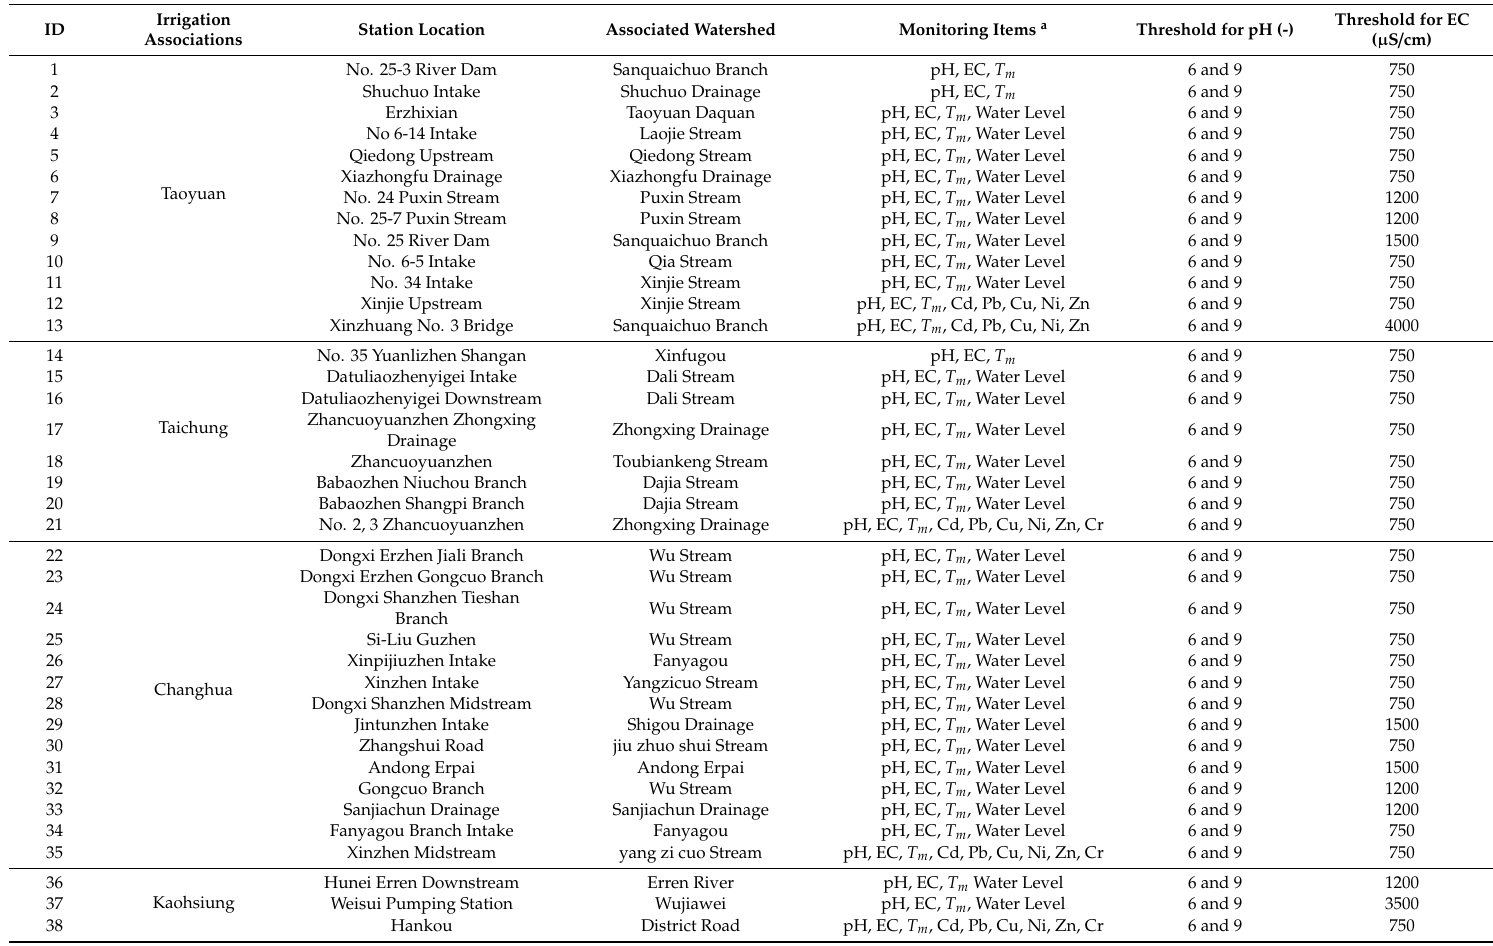
Table 2. Representative monitoring stations for basic water quality parameters of irrigation water in Taoyuan, Taichung, Changhua, and Kaohsiung. All stations feature automatic sampling function once the water quality exceeds the threshold